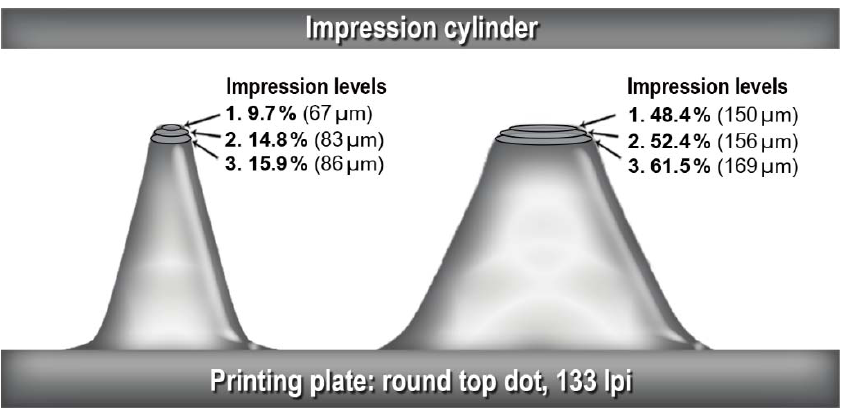
Figure 7. Schematic view of the variation of the impression level at three stages of printing for two characteristic halftone dots.